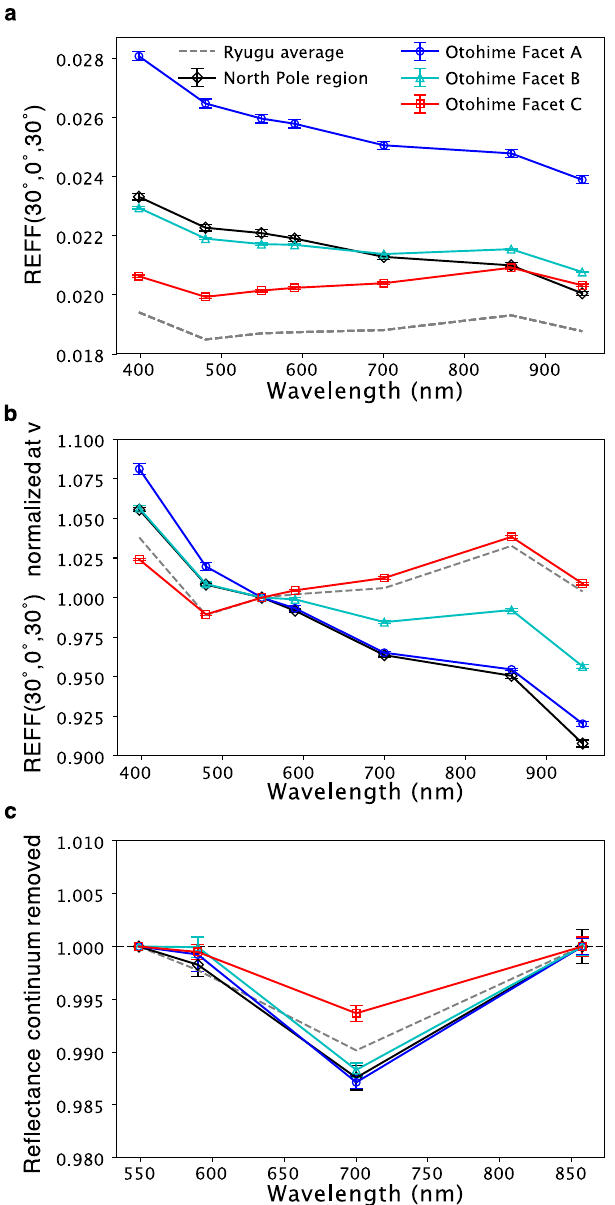
Fig. 2 Spectrophotometric characteristics of Otohime ’ s different facets and the north polar region. The region of interests are referred in Fig. 1. Standard error in the region of interests (Supplementary Fig. 1) are shown as error bars. a Absolute value of the re fl ectance factor at ( i, e, α ) = (30°, 0°, 30°). b Normalized spectra at v band of ( a ). c Continuum removed spectra over the v to x band